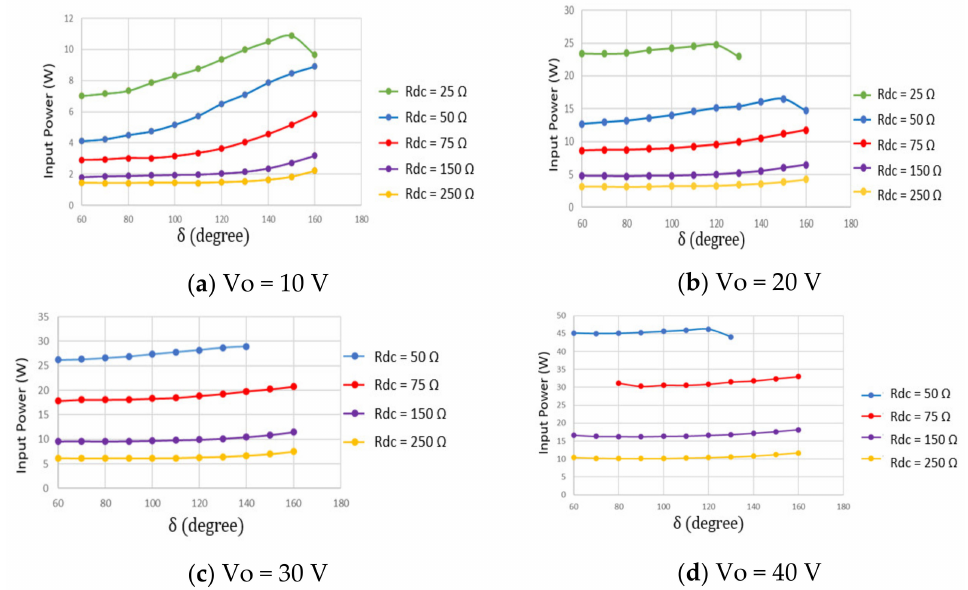
Figure 26. Input power vs. inverter-to-rectifier phase shift angle δ (deg) when DAB converter operating at Vdc = 30 V and Vo = 10 V, 20 V, 30 V. 40 V with different R dc